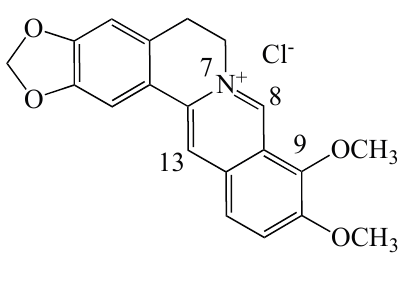
Figure 1. Chemical structure of berberine